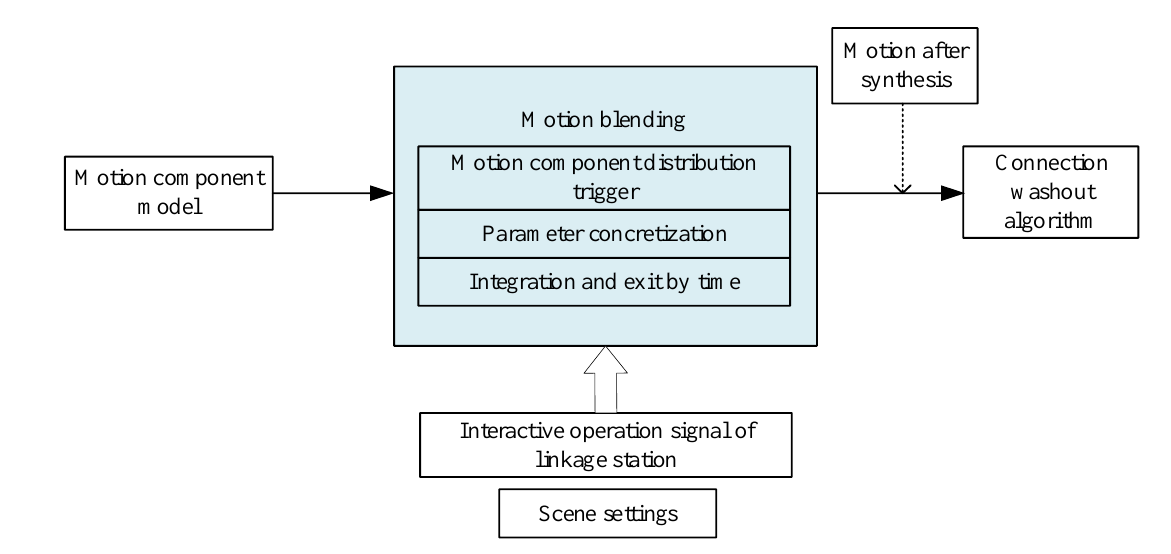
Figure 5. Motion blending technology in the trolley driving simulator.